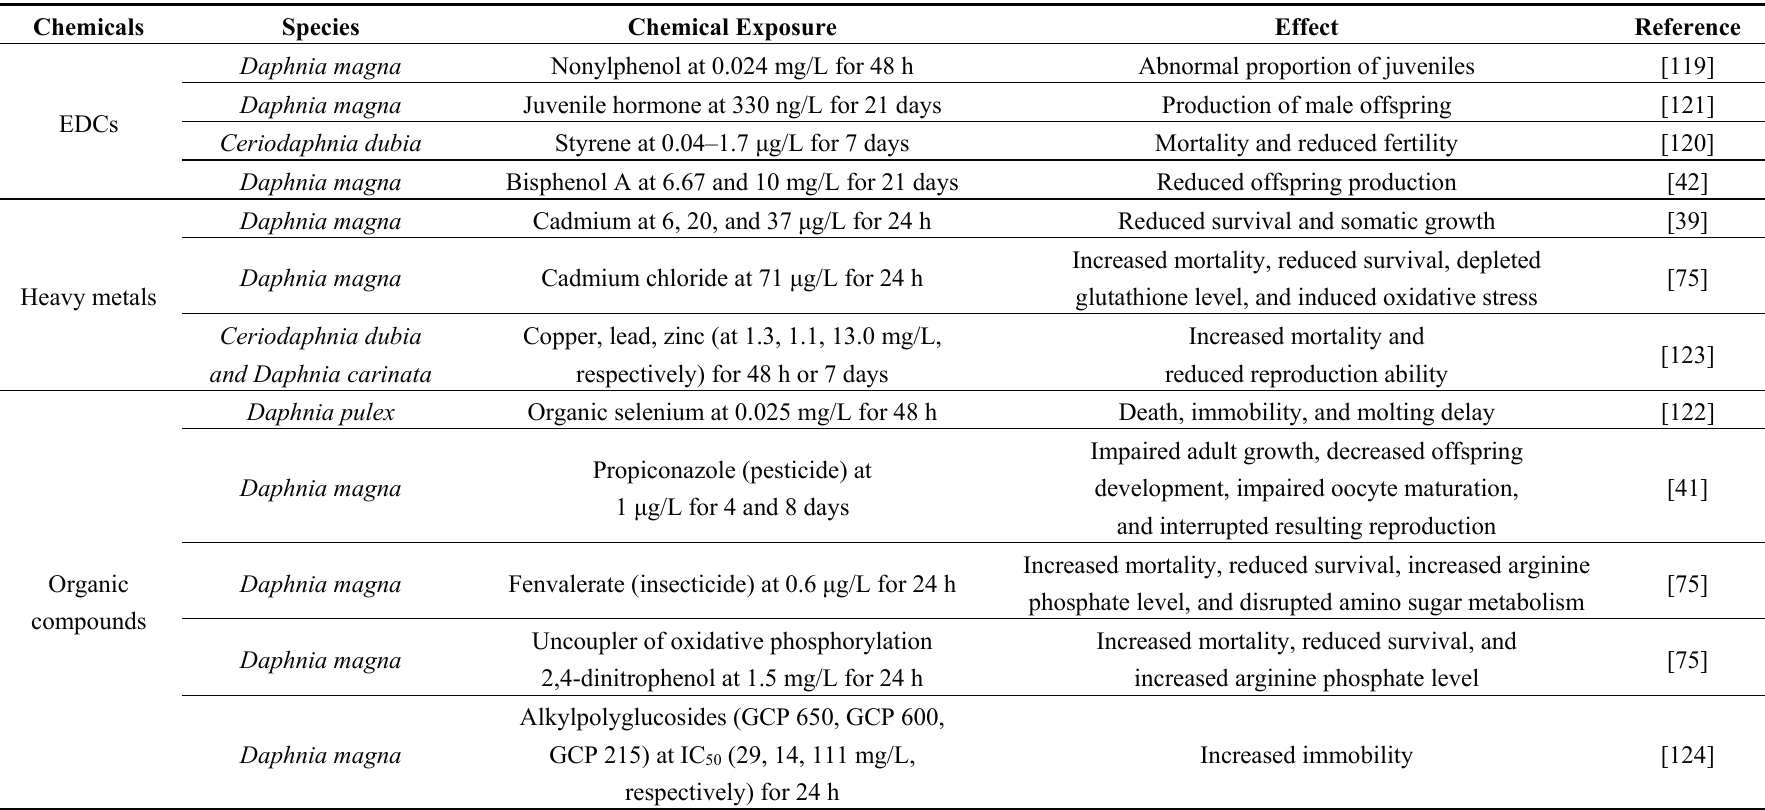
Table 1. Toxicological studies using daphnia system in response to potential environmental stressors including endocrine disrupting chemicals (EDCs), heavy metals, organic compounds, pharmaceutical drugs, and